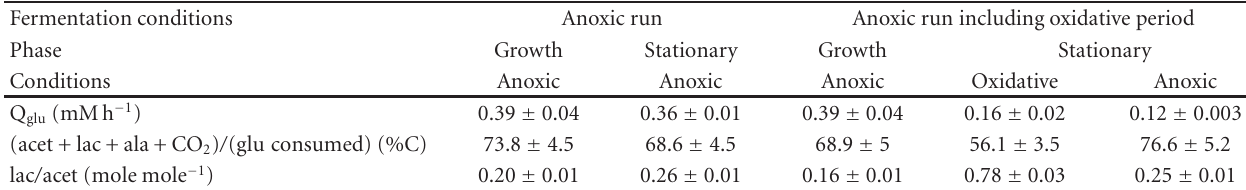
Table 3: Comparison of fermentative parameters of Thermotoga maritima during the anoxic fermentation run and the anoxic fermentation run including oxidative period.